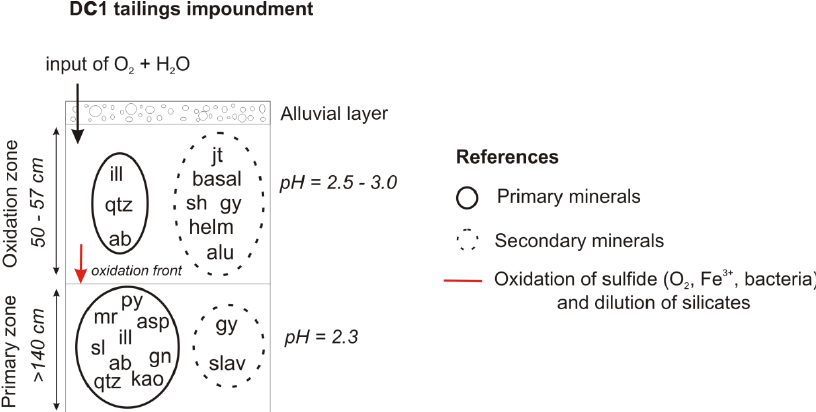
Figure 5. Scheme showing the main features, process, and mineralogy of DC1 tailings impoundment. Abbreviations are gy = gypsum; jt = jarosite; qtz = quartz; ab = albite; ill = illite; kao = kaolinite; py = pyrite; mr = marcasite; sl = sphalerite; gn = galena; asp = arsenopyrite; alu = alunite, basal = basaluminite; helm = helmuntwinkerite; slav =